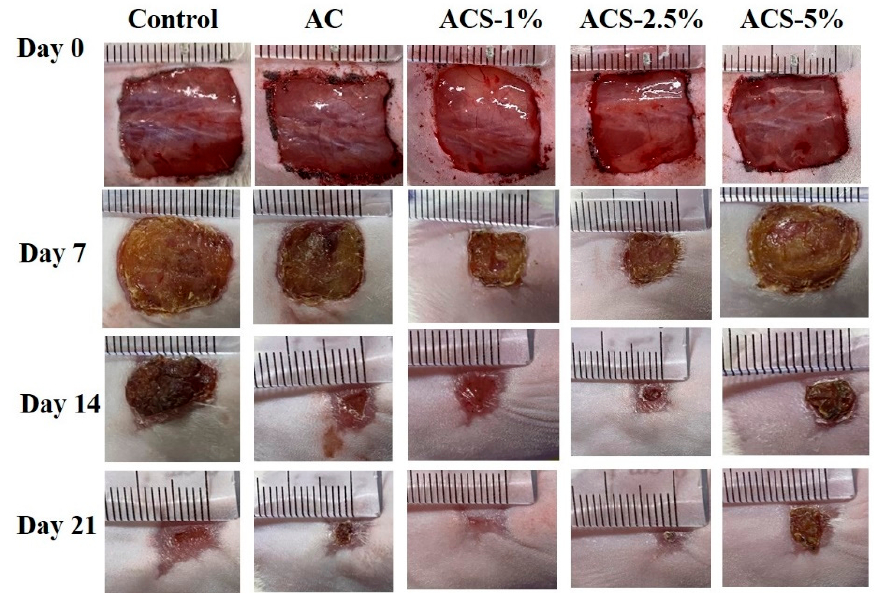
Figure 6. Photographs of wounds treated by sterile gauze (control), AC, ACS—1%, ACS—2.5%, and ACS—5% sponges at 0, 7, 14, and 21 days.